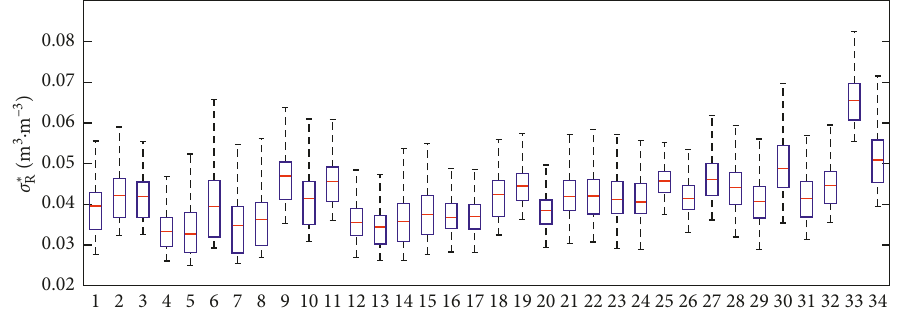
Figure 6: Standard deviation ( σ ) of the observation error for the rescaled ESA CCI SM at each grid within the basin. The upper limb, the R lower limb, and the red line in the box plot represent the upper quartile ( h 1 ), the lower quartile ( h 2 ), and the median value of σ ∗ 2003–2006. The dotted line stretched from the box is the range between h 1